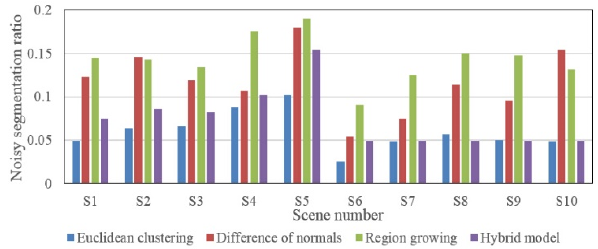
Figure 8. Unlabeled noisy segmentation ratio for ten indoor scenes processed by four segmentation